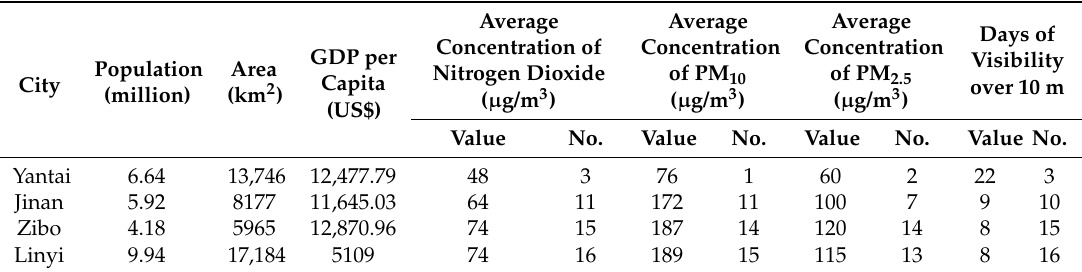
Table 1. Sample sizes and air quality of the four cities in Shandong province (among 17 cities in November, 2014).